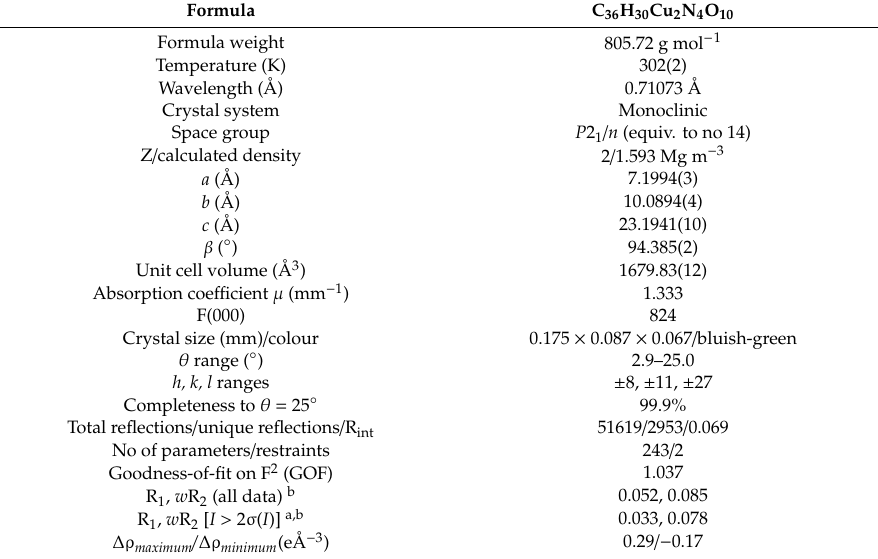
Table 4. Crystal data and refinement parameters for compound 1